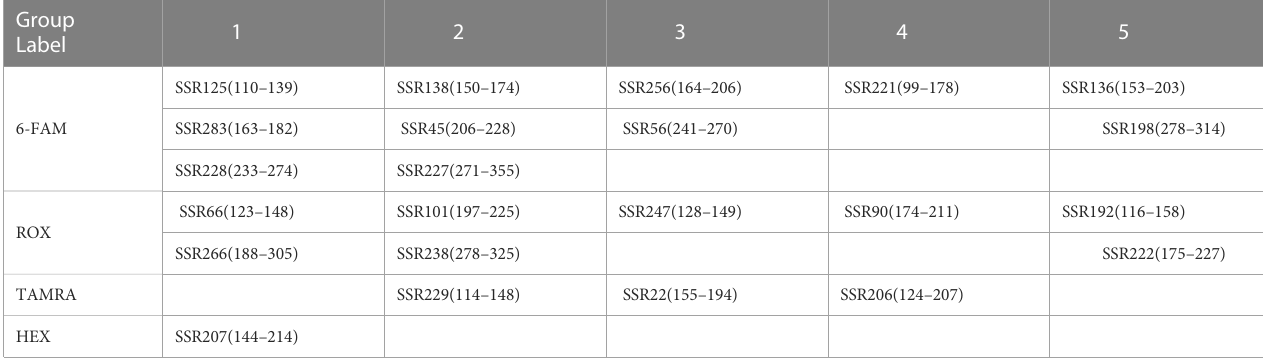
TABLE 4 Grouping of 23 core primers according to different fl uorescent-labelled colors. Group